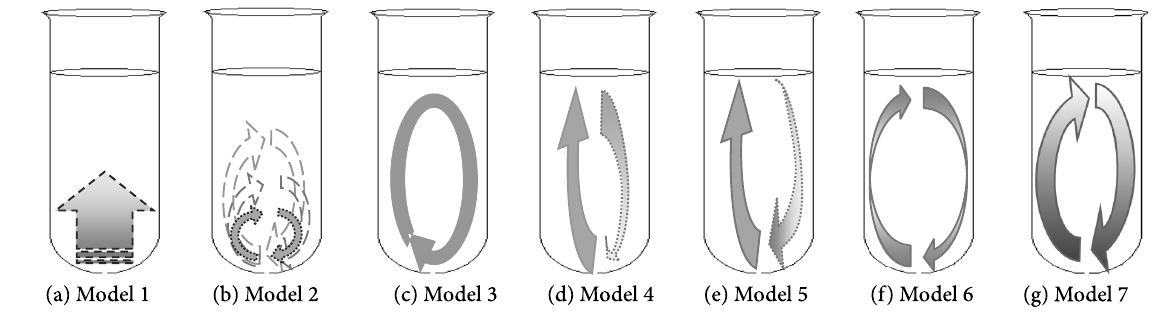
FIG. 2. Illustrations of the seven mental